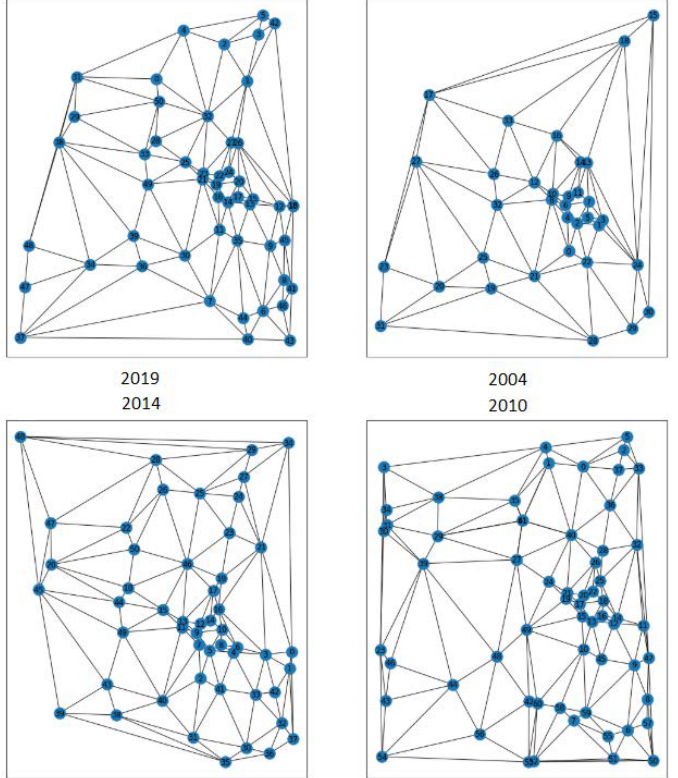
Figure 13. An example of the graph representation of the nearly identical geographical zone across 4